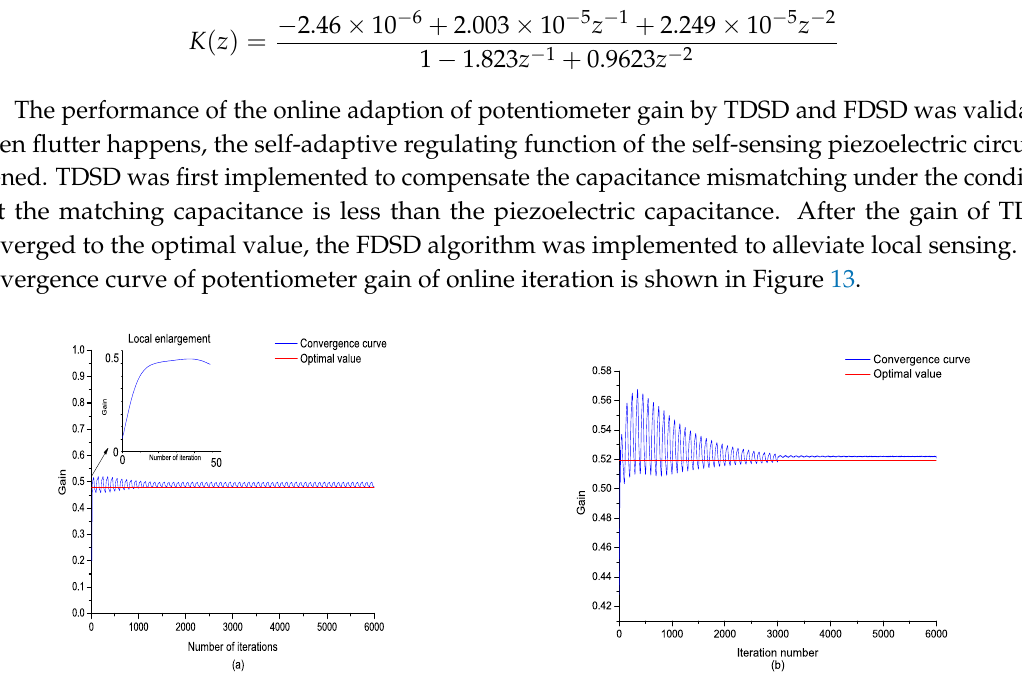
Figure 13. ( a ) TSDS convergence curve of online iteration; ( b ) frequency domain steepest descent (FDSD) convergence curve of online iteration.